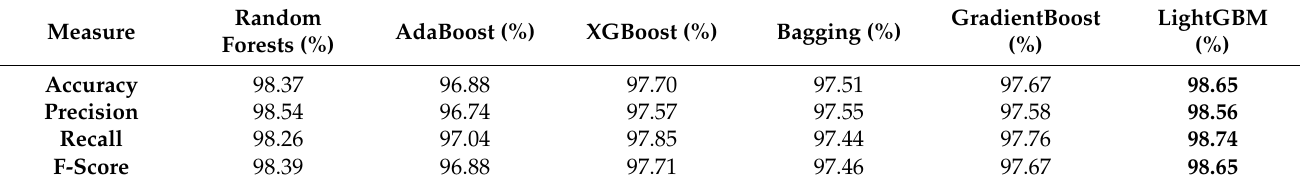
Table 3. Performance of ensemble classifiers for Dataset 2.